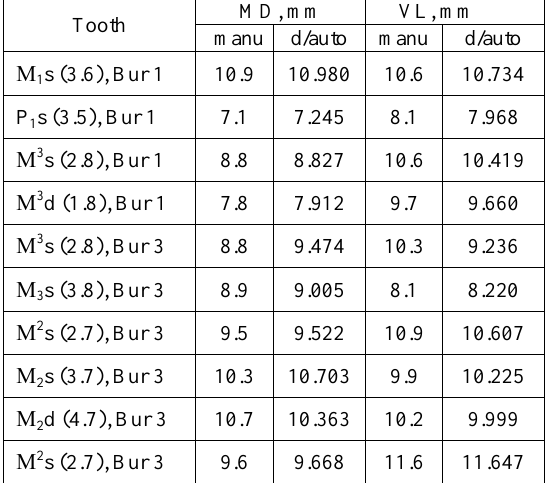
Table 11. MD and VL odontometry; measurement results.